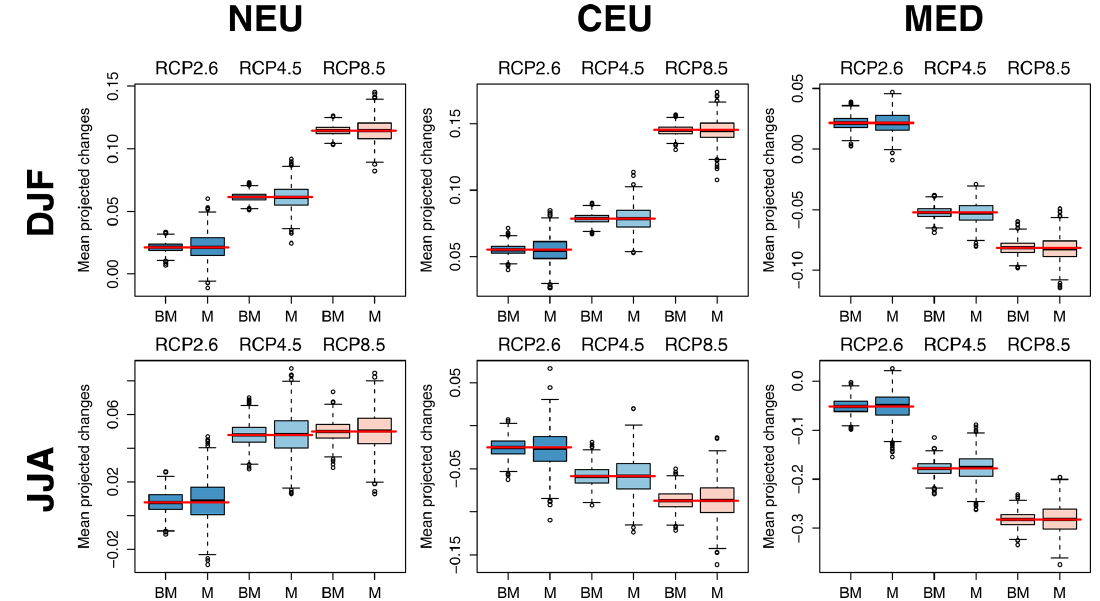
Figure 15. Comparison of mean projected change estimates for precipitation using QUALYPSO (BM) and direct averages ( M ) of a synthetic MME for each RCP scenario, SREX region, and season. A complete synthetic MME composed of 9 GCMs × 13 RCMs × 3 RCPs = 351 chains is generated using the ANOVA effects and the residual variability estimated with the original MME. Each box plot shows the distri- bution of the 1000 mean change estimates obtained with the 1000 incomplete MMEs (87 chains) randomly subsampled from the complete synthetic MME (351 chains). Each incomplete MME includes at least one chain for each of the 9 GCMs, 13 RCMs, and 3 RCPs. Red horizontal lines indicate the corresponding averages obtained from the complete